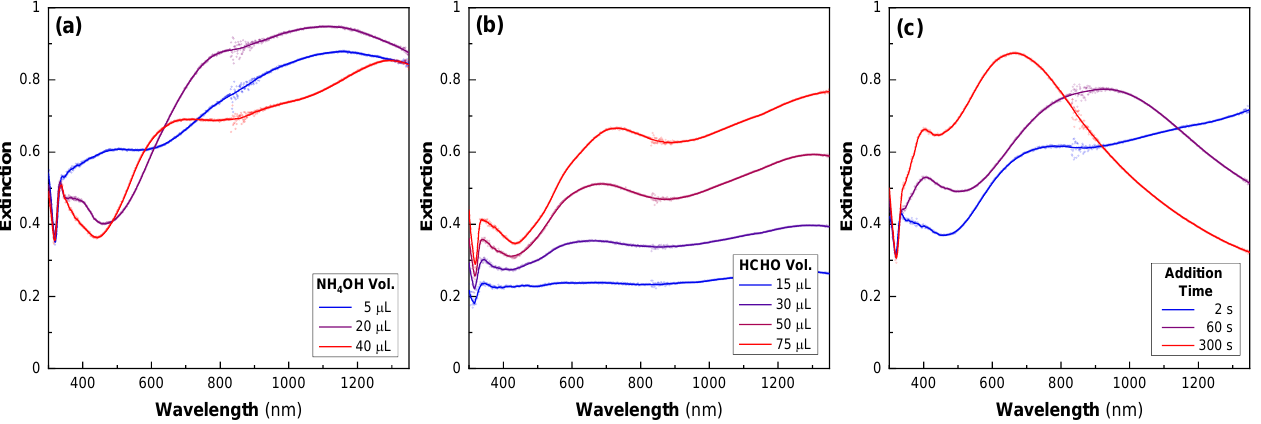
Figure 5. Effect of multiple parameters on the Ag-nanoshell synthesis. The UV – Vis – NIR spectra after the shell-growth step, prepared using different amounts of ( a ) ammonia, ( b ) formaldehyde, and ( c ) different times between the injection of formaldehyde and ammonia, all other conditions being equal.